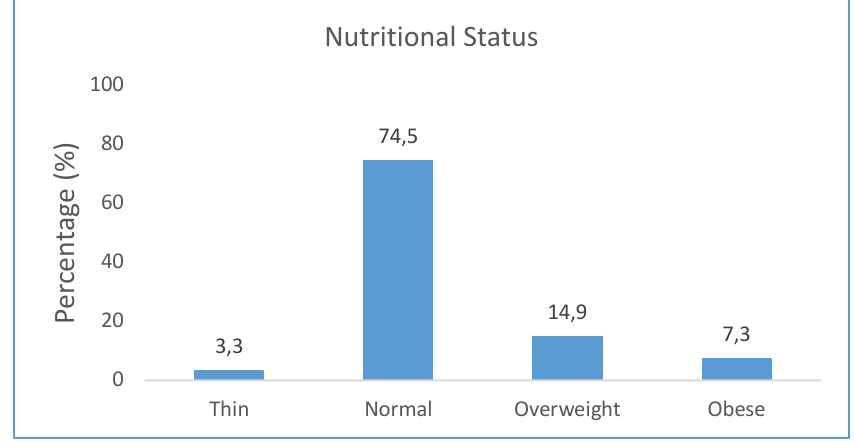
Figure 1. Nutritional status of the subjects Table 1 . The SDQ scores categories